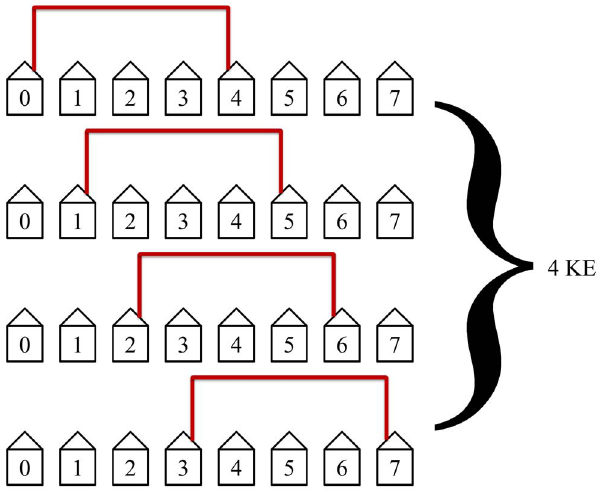
Figure 10. The fourth step in the protocol connects the fourth nearest neighbors. This step is the slowest and least efficient step in the protocol in our example of N= 7. This step requires 4 KEs to